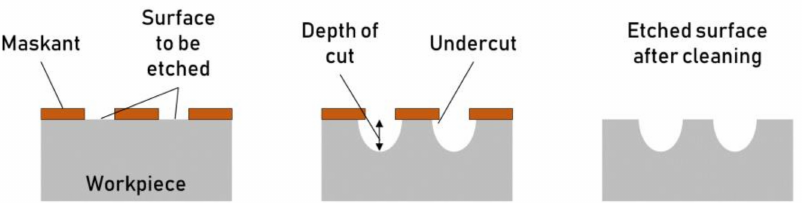
Figure 5. Bi-directional material removal, downward—depth of cut—and laterally—undercut—from the exposed